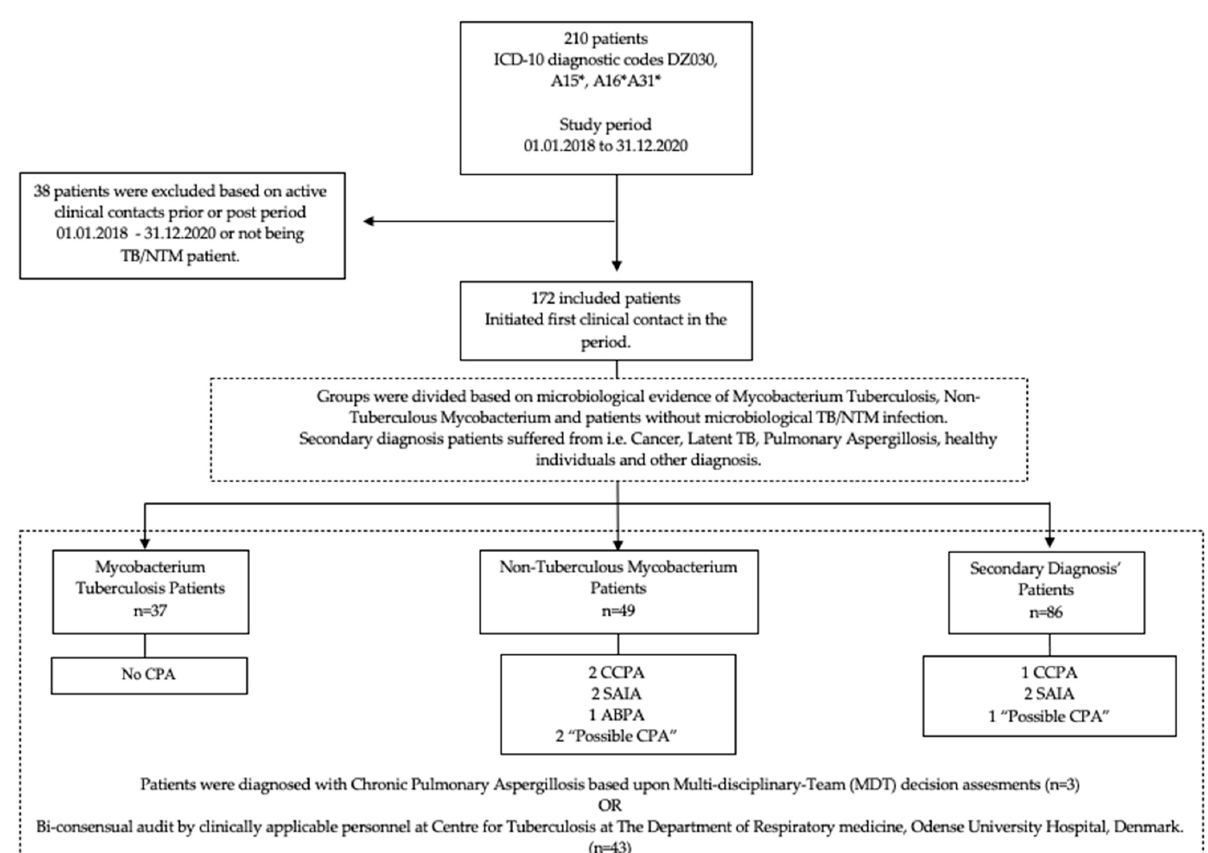
Figure 1. Flowchart of study population.